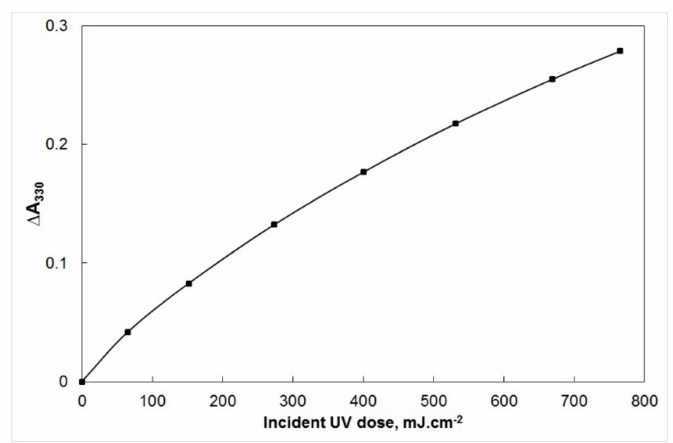
Figure 1. The first dose-response curve of polysulphone (PSP) film, showing the variation of ∆ A 330 with incident ultraviolet exposure at a wavelength of 297 nm [4].